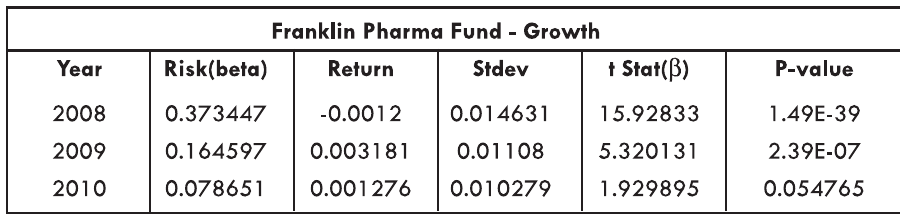
Table 2: Risk and Returns of Franklin Pharma Fund - Growth Scheme during the Study Period (2008 to 2010)